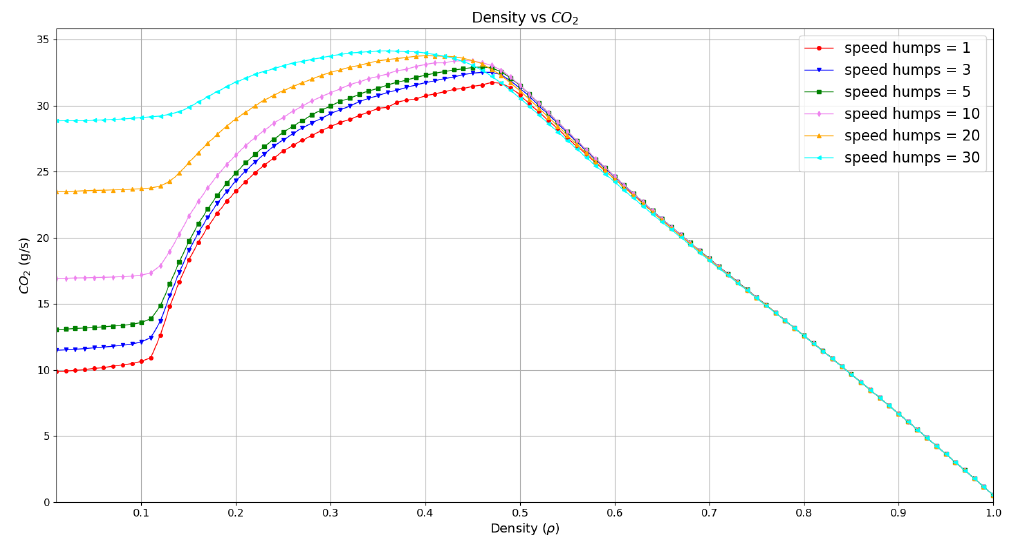
Figure 7. CO 2 instant emissions as a function of density.